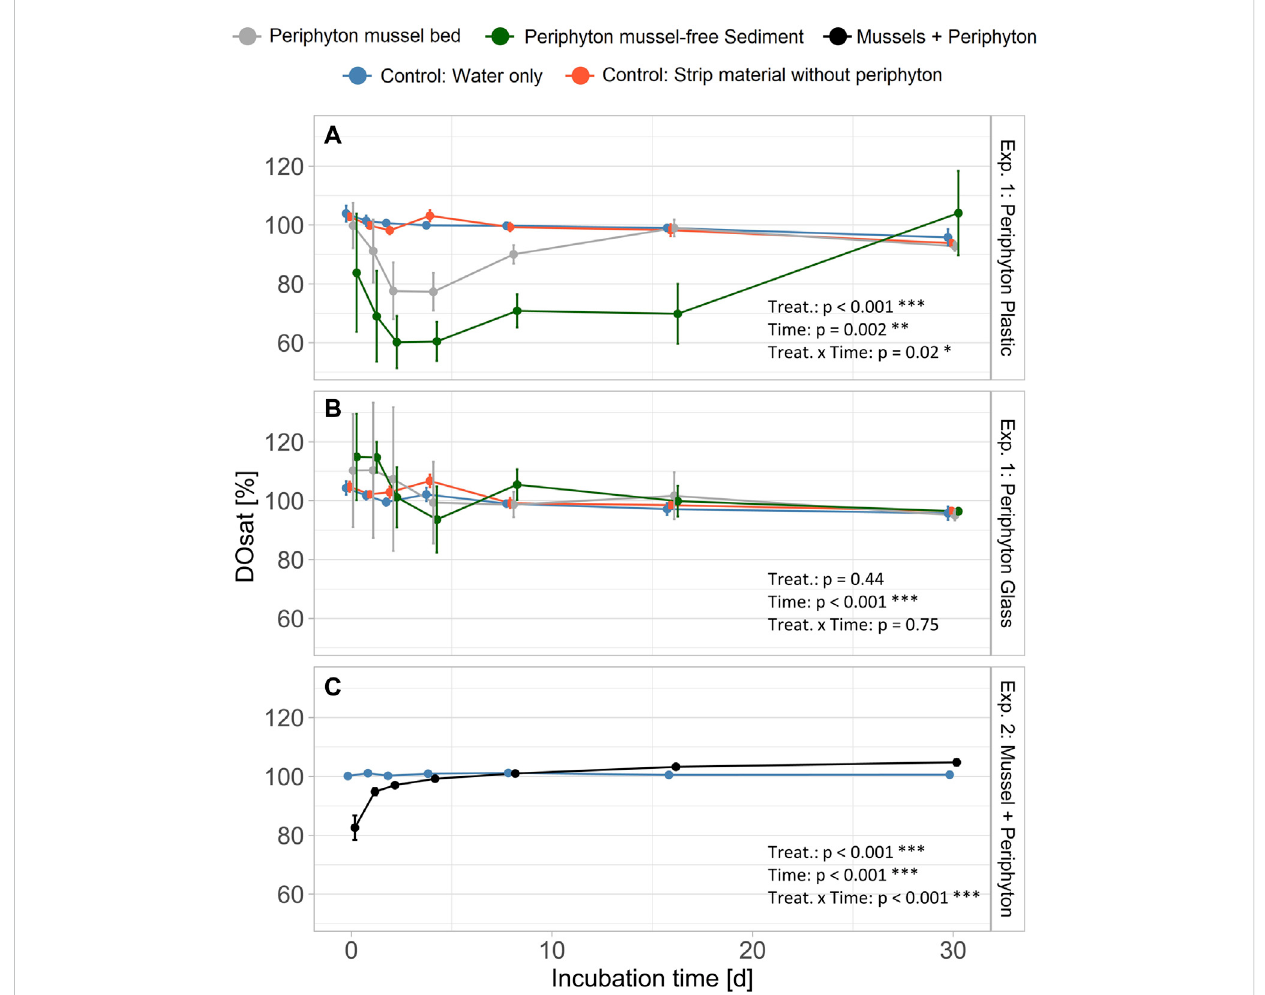
FIGURE 4 Dissolved oxygen saturation (DO sat ) for batch experiment (Exp.) 1 (A) :periphyton grown on plastic and (B) glass strips, batch Exp. 2 (C) : mussels with periphyton). Bars indicate standard error. Position of the points is dodged to allow better visibility of error bars. Aligned Rank Transform (bottom right corner) showssigni fi cantdifferencesfor treatment(treat.)andtime (*: p < 0.05;**: p < 0.01;***: p < 0.001). Inallexperiments,weusedfourreplicatesfor each of the controls and